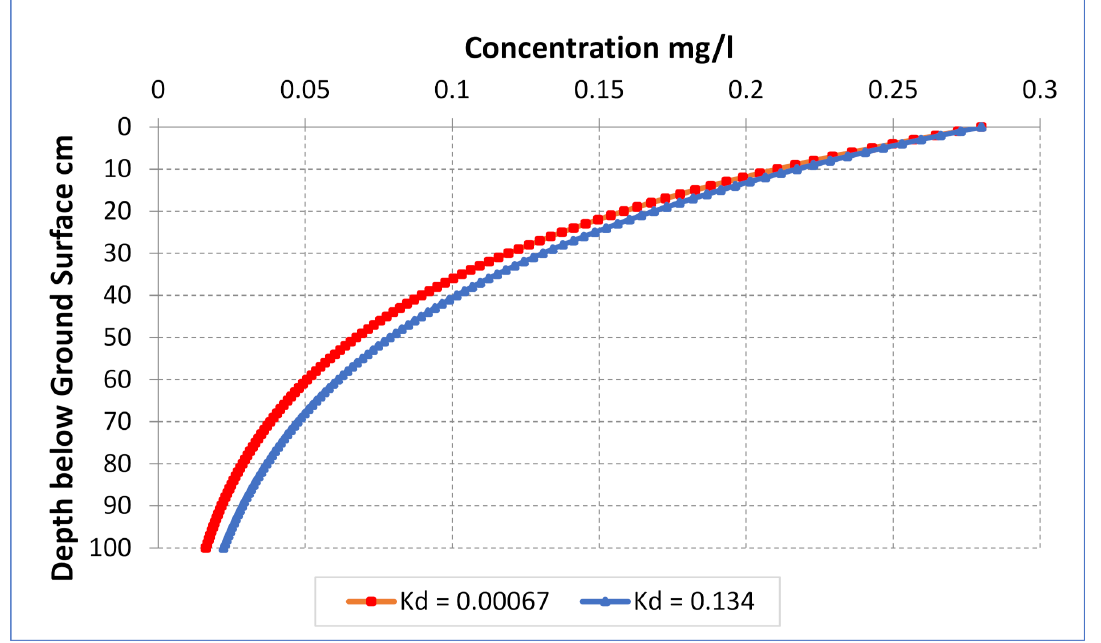
Figure 6. The effect of the distribution coefficient ( K d )—Sandy clay